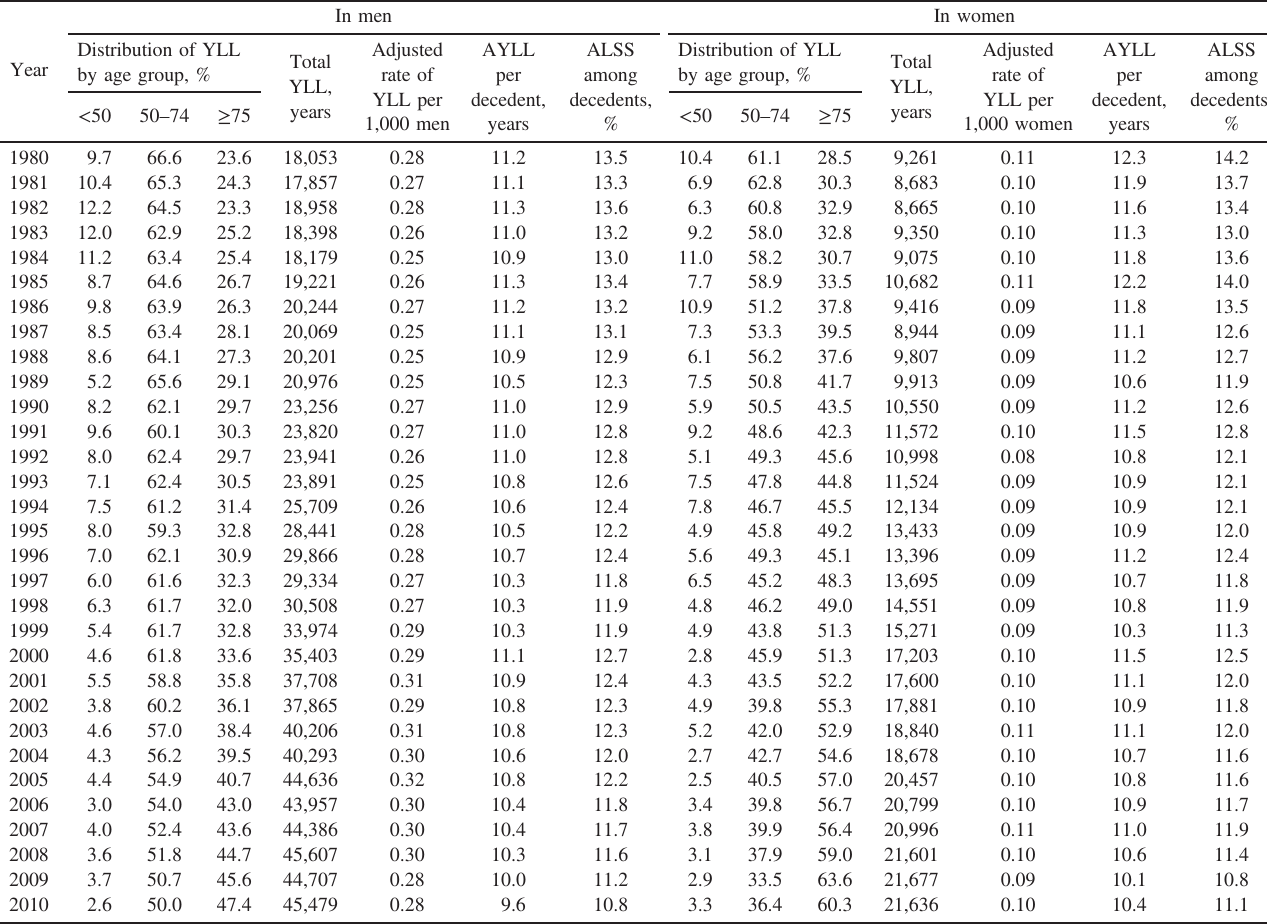
Adjusted rate of